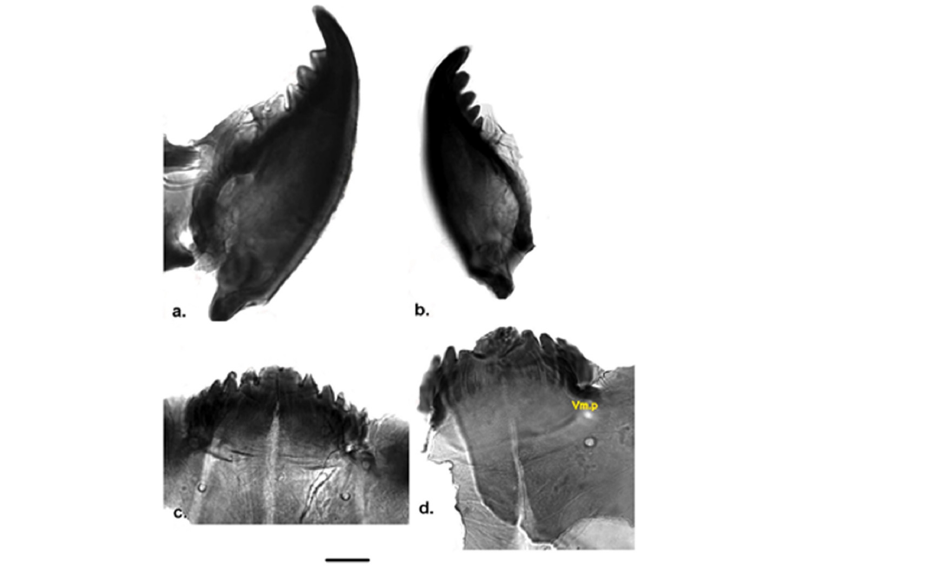
Figure 2. Larva morphology of Belgica antarctica (Jougla Point). ( a ) Mandible with four teeth; ( b ) Mandible with five teeth; ( c ) Mentum; ( d ) Mentum with malformation and clearly visible ventro- mental plate (vm. p). Scale bar 10 µm.